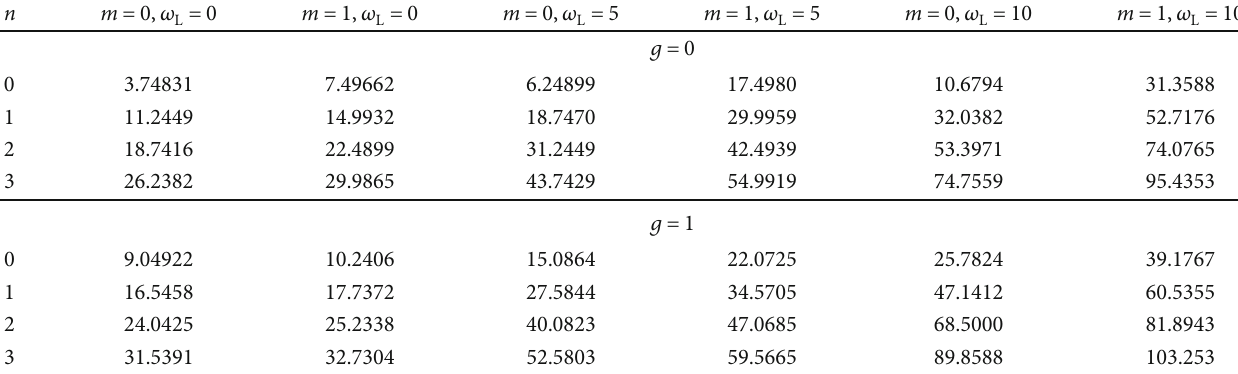
Table 6: Energy spectra for H molecules bounded by the isotropic oscillator plus inverse quadratic potential for arbitrary Larmor 2 . frequencies ω L